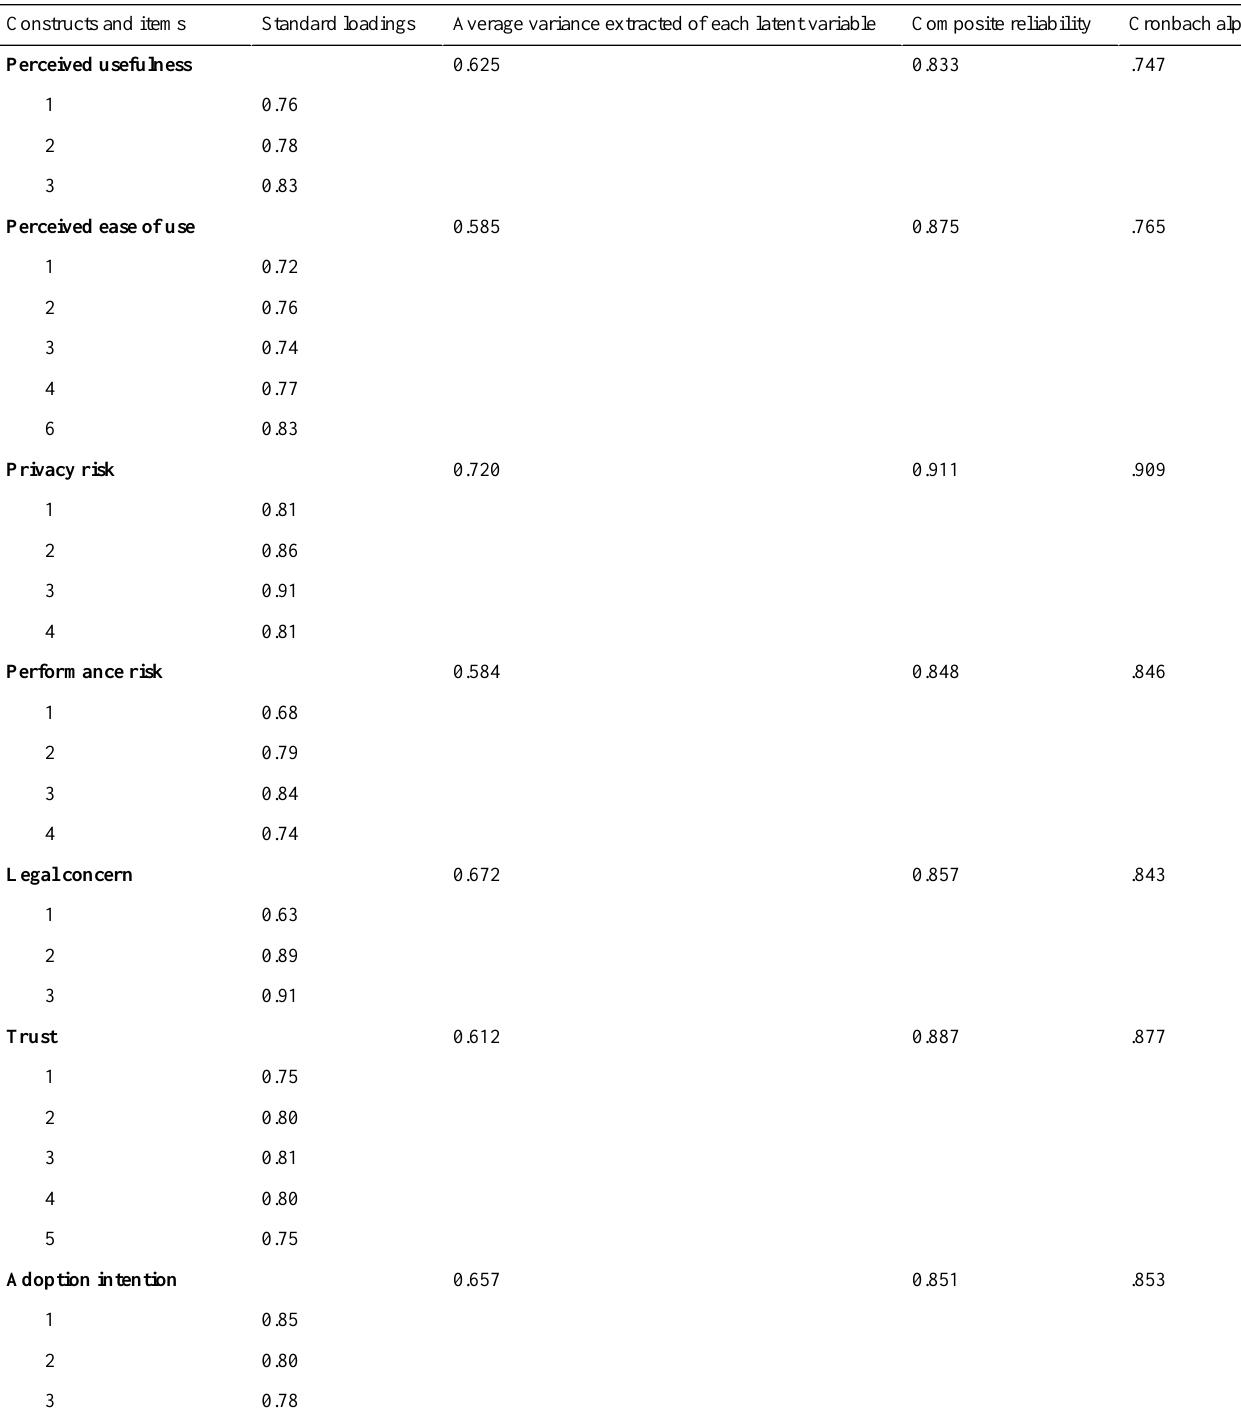
Table 2. Confirmatory factor analysis results of the measurement